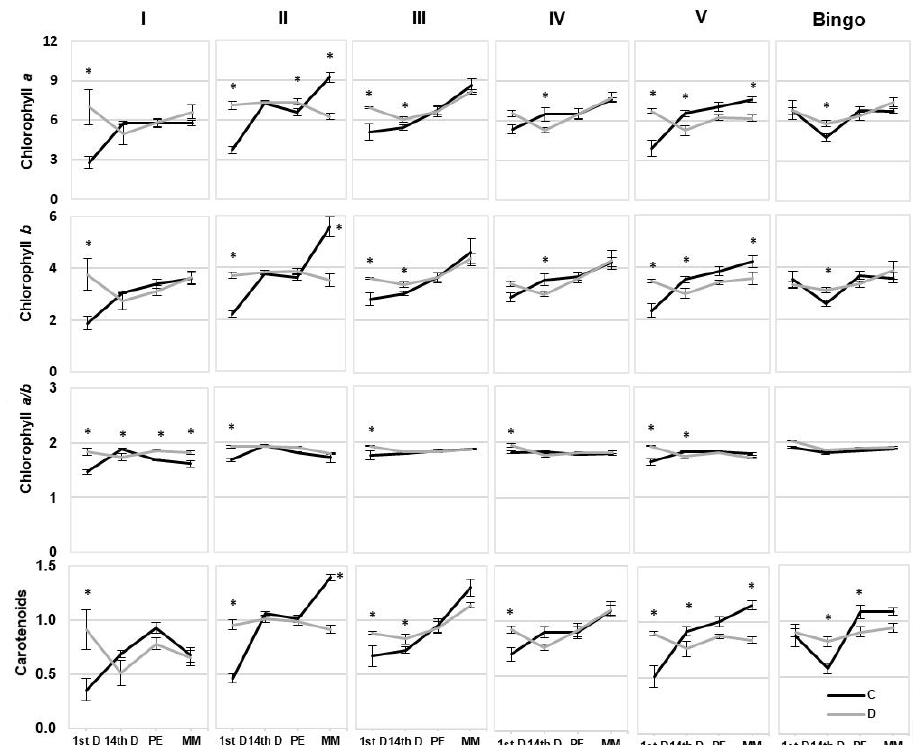
Figure 7. The content of photosynthetic pigments [µg/mL] in the leaves of OMA lines and cv. Bingo on the 1st day of drought (1stD), 14th day of drought (14thD), panicle ejection phase (PE), and kernel milk maturity phase (MM). C—control, 70% FWC, black line; D—drought, 25% FWC, grey line. The mean values (n = 5) ± SE marked with an asterisk (*) are significantly different at p ≤ 0.05 according to the Student’s t test.